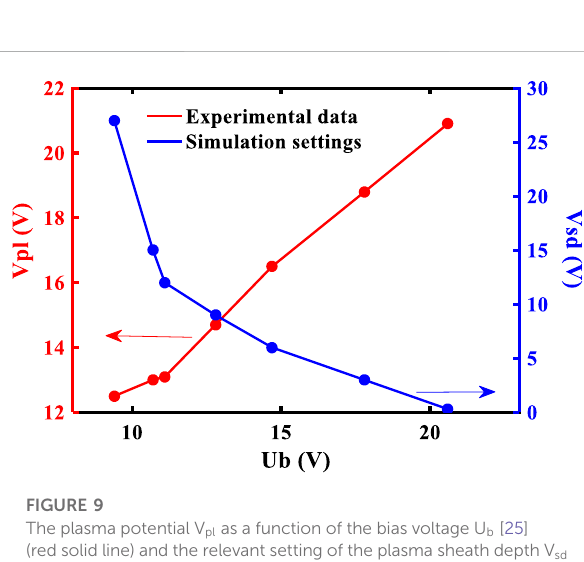
FIGURE 9 The plasma potential V pl as a function of the bias voltage U b [25] (red solid line) and the relevant setting of the plasma sheath depth V sd in front of the PG in this model (blue solid line) under the BATMAN hydrogen working gas of 0.6 Pa.